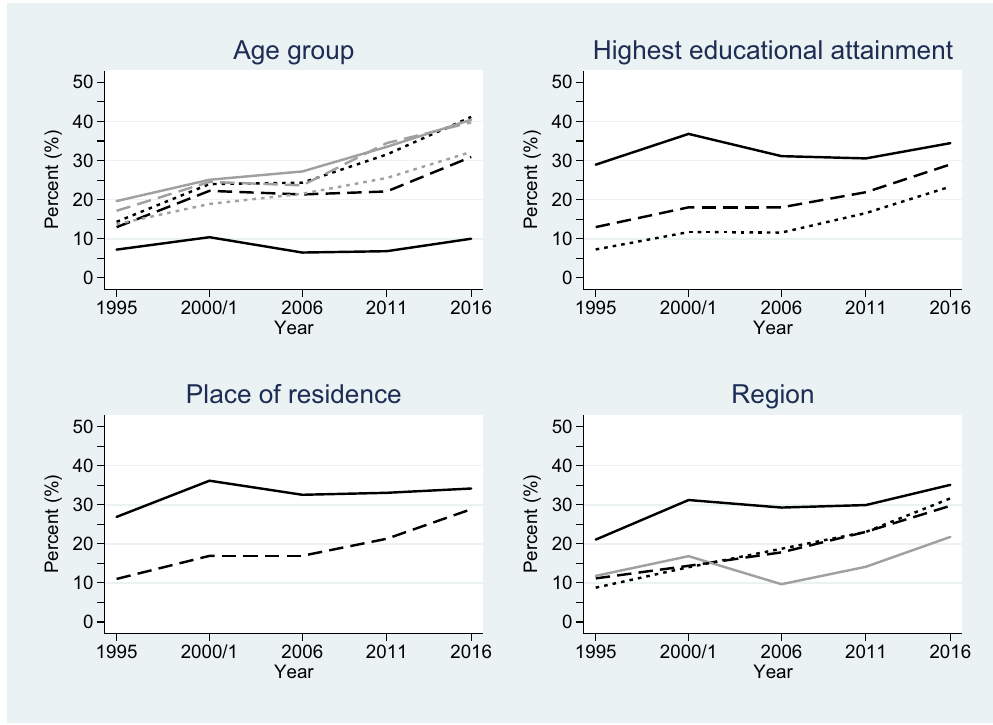
Fig 2. Changes in any contraceptive use among women in Uganda across the study period (1995–2016), partitioned by the considered demographic variables. Key: age group (years): 15–19 (black/solid); 20–24 (black/dash); 25–29 (black/dot); 30–34 (grey/solid); 35–39 (grey/dash); � 40 (grey/dot); highest educational attainment: secondary and higher (solid); primary (dash); none (dot); place of residence: urban (solid); rural (dash); and region: Central (black/solid); East (dash); West (dot); North